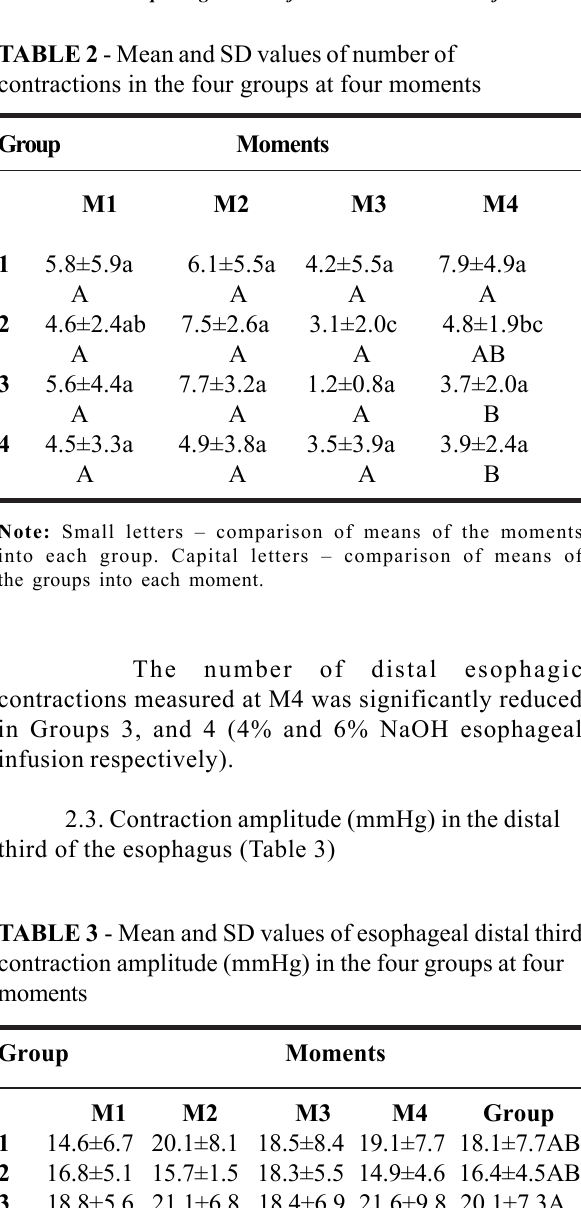
TABLE 2 - Mean and SD values of number of contractions in the four groups at four moments Group Moments